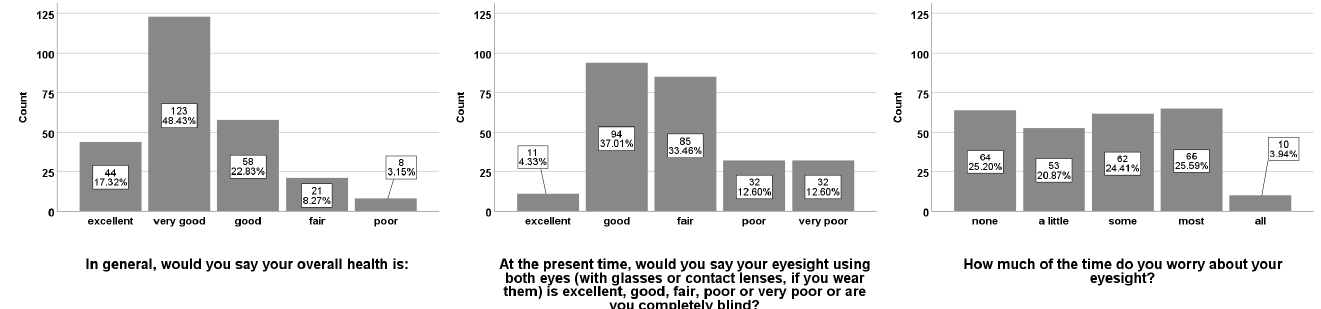
Figure 3. Results from the Visual Field Questionnaire—25 (VFQ-25) assessments. Answers to the questions, “In general, would you say your overall health is:”, “At the present time, would you say your eyesight using both eyes (with glasses or contact lenses, if you wear them) is excellent, good, fair, poor or very poor or are you completely blind?” and “How much of the time do you worry about your eyesight?” Results for each bar are shown in absolute numbers and percentages.